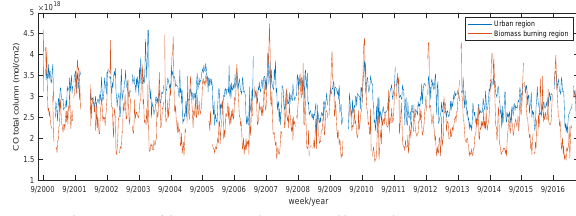
Dongsha island and Lulin Mountain. The ratio of the standard deviation to the mean at Lulin is found to be 1.27, while the ratio of the standard deviation to the mean is found to be 0.68.